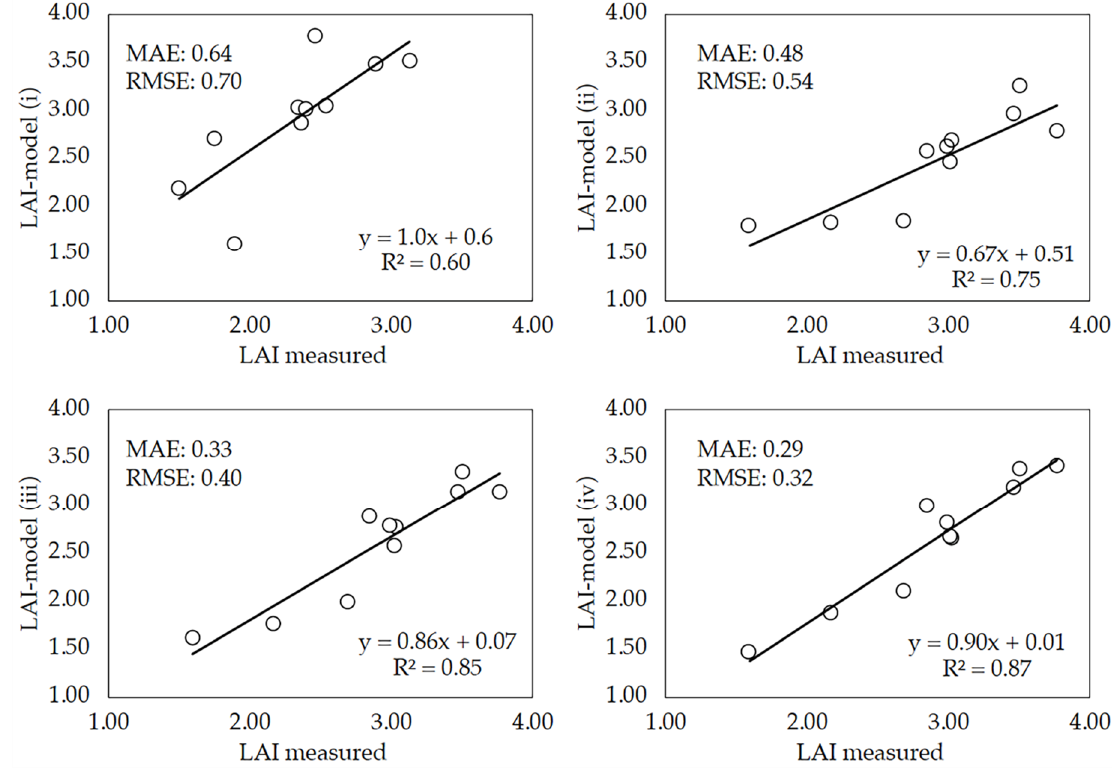
Figure 9. Linear regressions between measured LAI (direct method) and LAI estimates made by the four model versions (LAI-model). LAI-model (i): the model was trained using only red green blue (RGB) images, canopy cover (CC) value and LAI; LAI-model (ii): the plant height was added as additional parameter together with those previously used; LAI-model (iii): the mean leaf area of individual wheat leaves was added; LAI-model (iv): the days after sowing (DaS) was included as an input to train the model. Each point is the mean of three replicates per wheat cultivar.